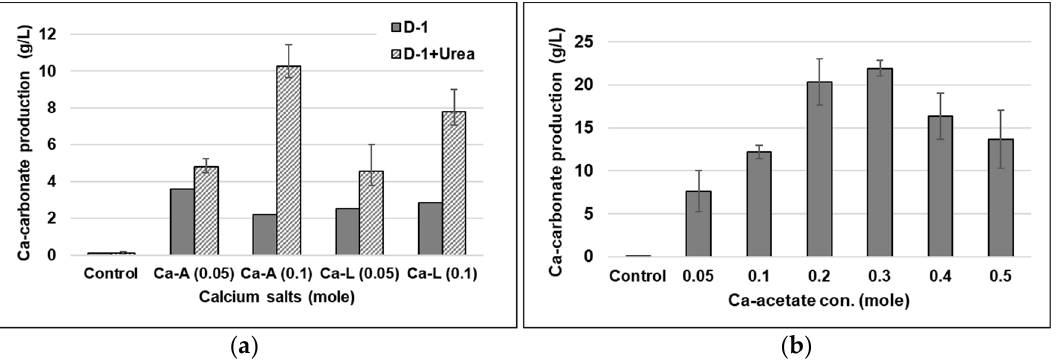
Figure 5. ( a ) The effects of Ca-ion species, Ca-concentration, urea, and ( b ) various concentrations of Ca-acetate on Ca-carbonate yield. Ca-acetate on Ca-carbonate